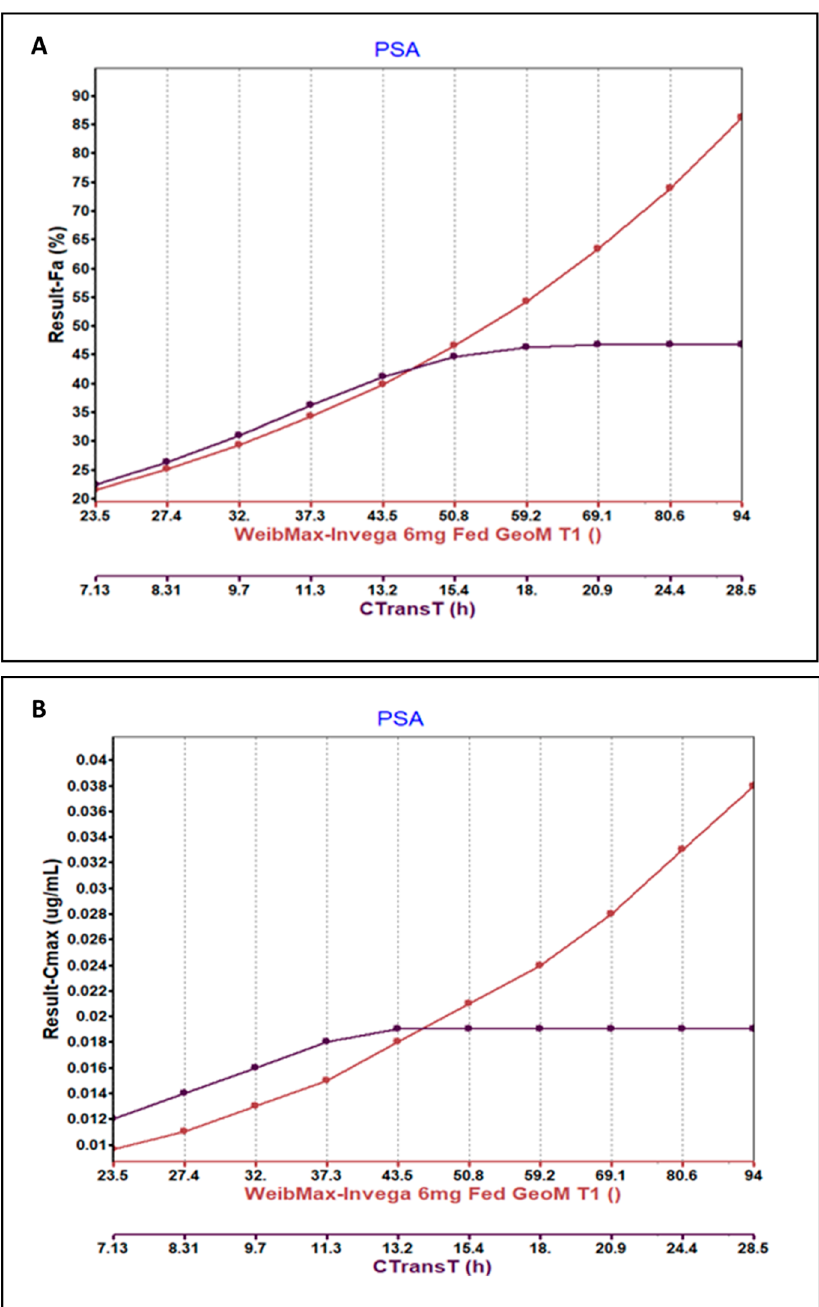
Figure 6. Parameter sensitivity analysis plot showing ( A ) fraction absorbed (%) vs. 2 axes: (a) red